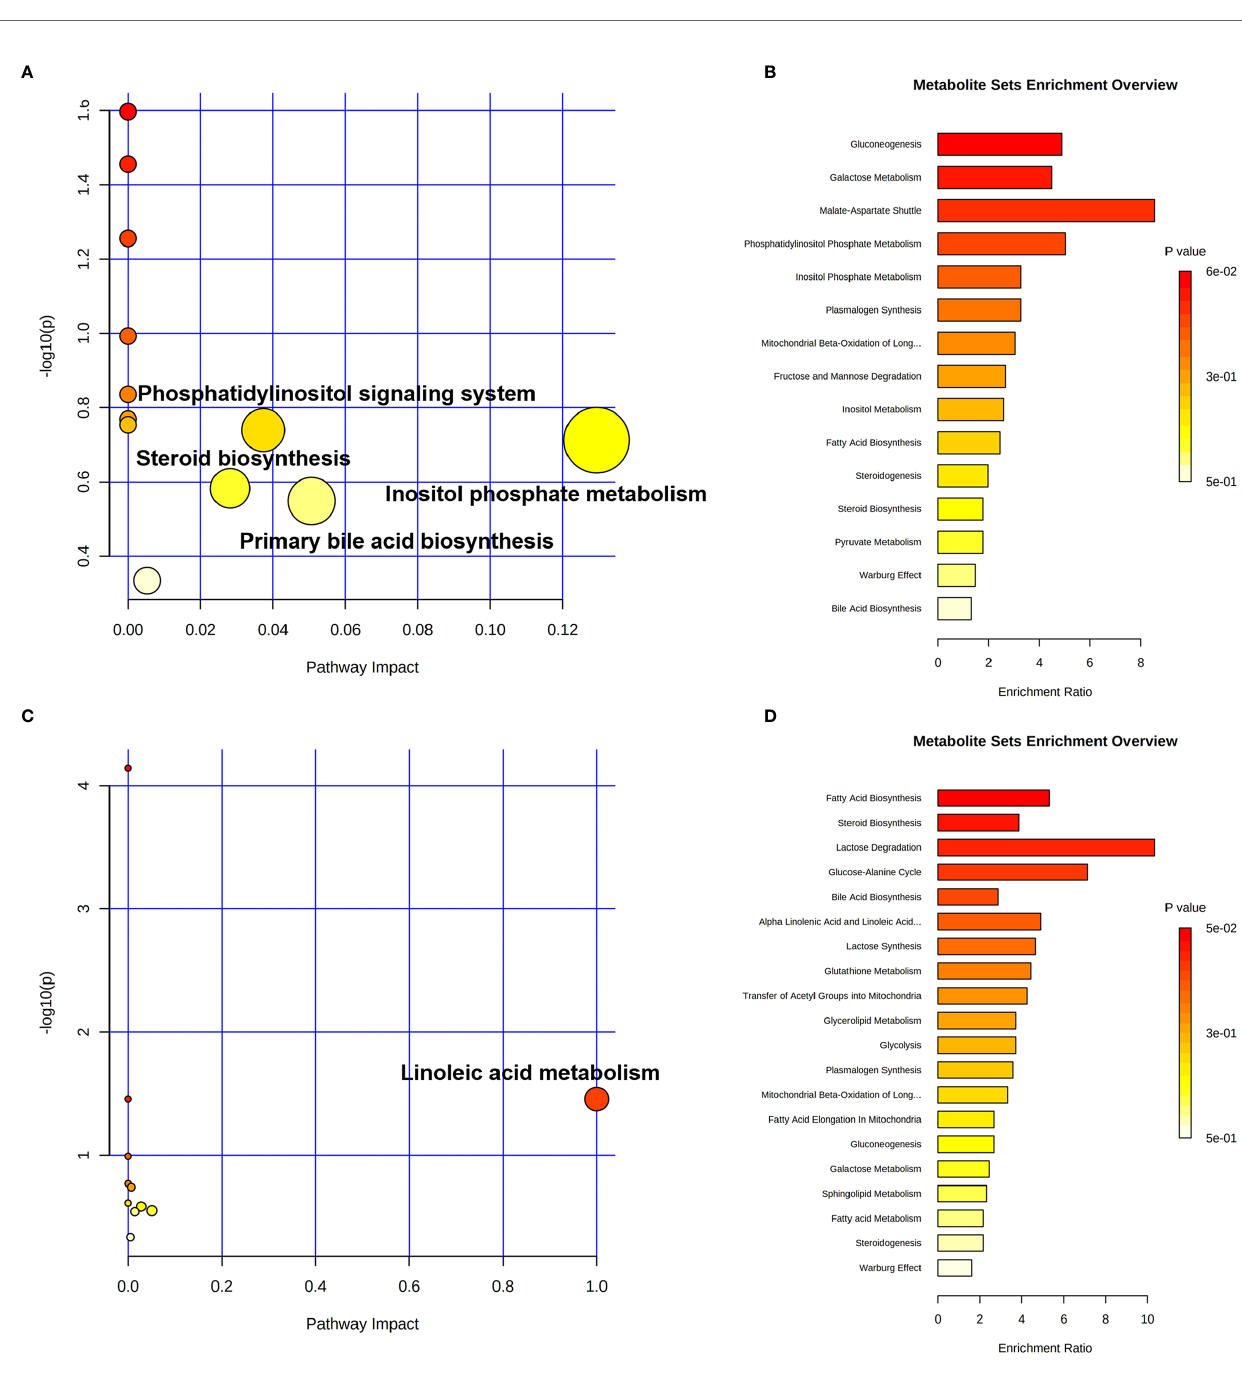
FIGURE 6 | Pathway enrichment analysis of CRC in cancer tissue and paracarcinoma tissue samples (A, B) and preoperative and postoperative serum of 2-week sample (C, D)